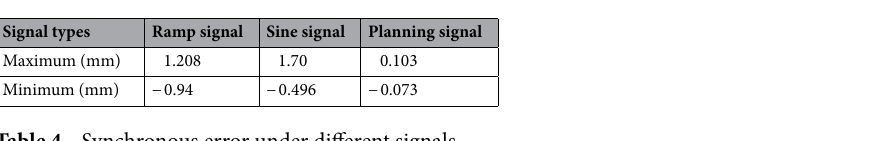
Table 4. Synchronous error under different